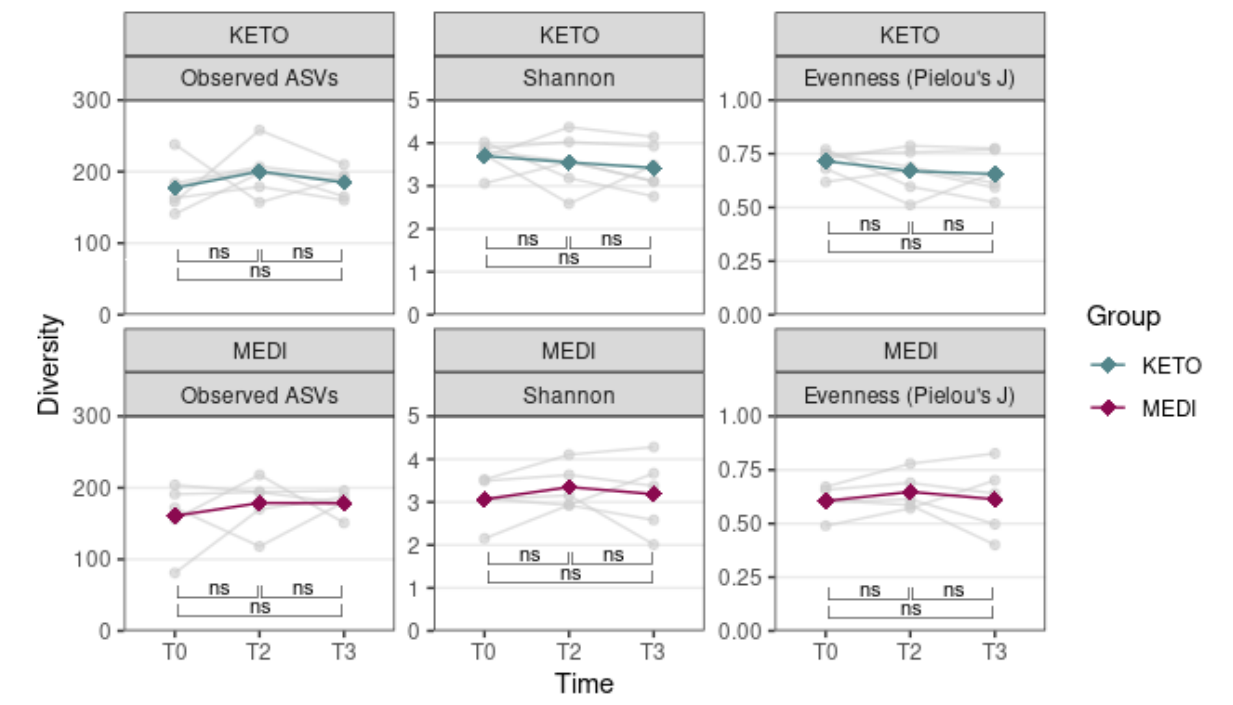
Figure 3. Gut microbiota alpha diversity comparison between time points for each diet. Each subplot concerns a different combination of alpha diversity metric (Observed ASVs, Shannon, or Pielou’s J) and diet (KETO or MEDI). Samples from the same patient are linked by a gray line. The colored lines depict the mean values at each timepoint. Statistical significance was evaluated by the paired Wilcoxon signed-rank test, and it was indicated as follows: ns, non-significant. KETO = 6 patients who followed a very-low-calorie ketogenic diet (VLCKD), MEDI = 5 patients who followed a low-calorie Mediterranean diet (MD). Samples were analyzed at baseline (T0), after two months (T2), and after three months (T3) of nutritional intervention.